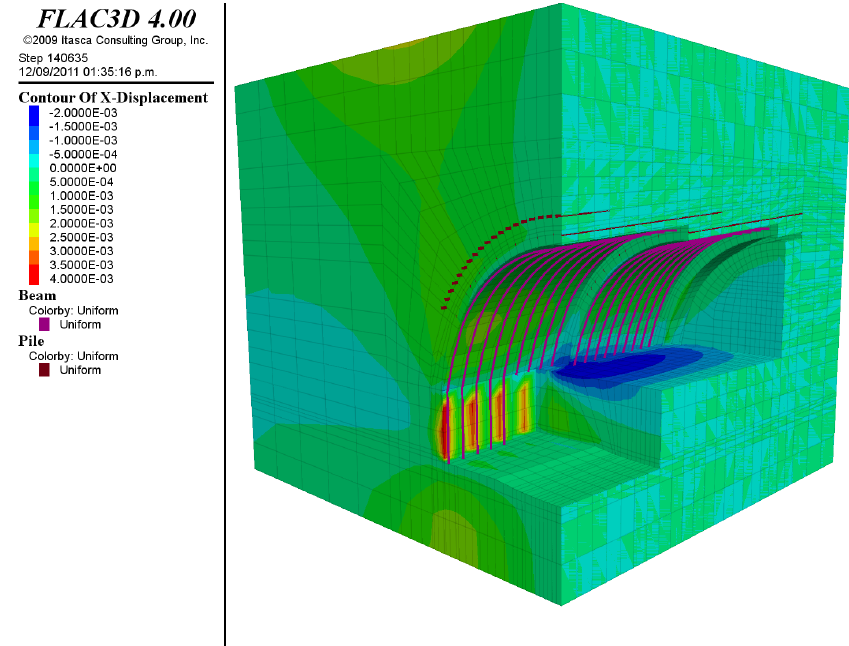
Figure 18. Horizontal displacements (Ux in meters) in an intermediate stage of the excavation. Minimum parameters.